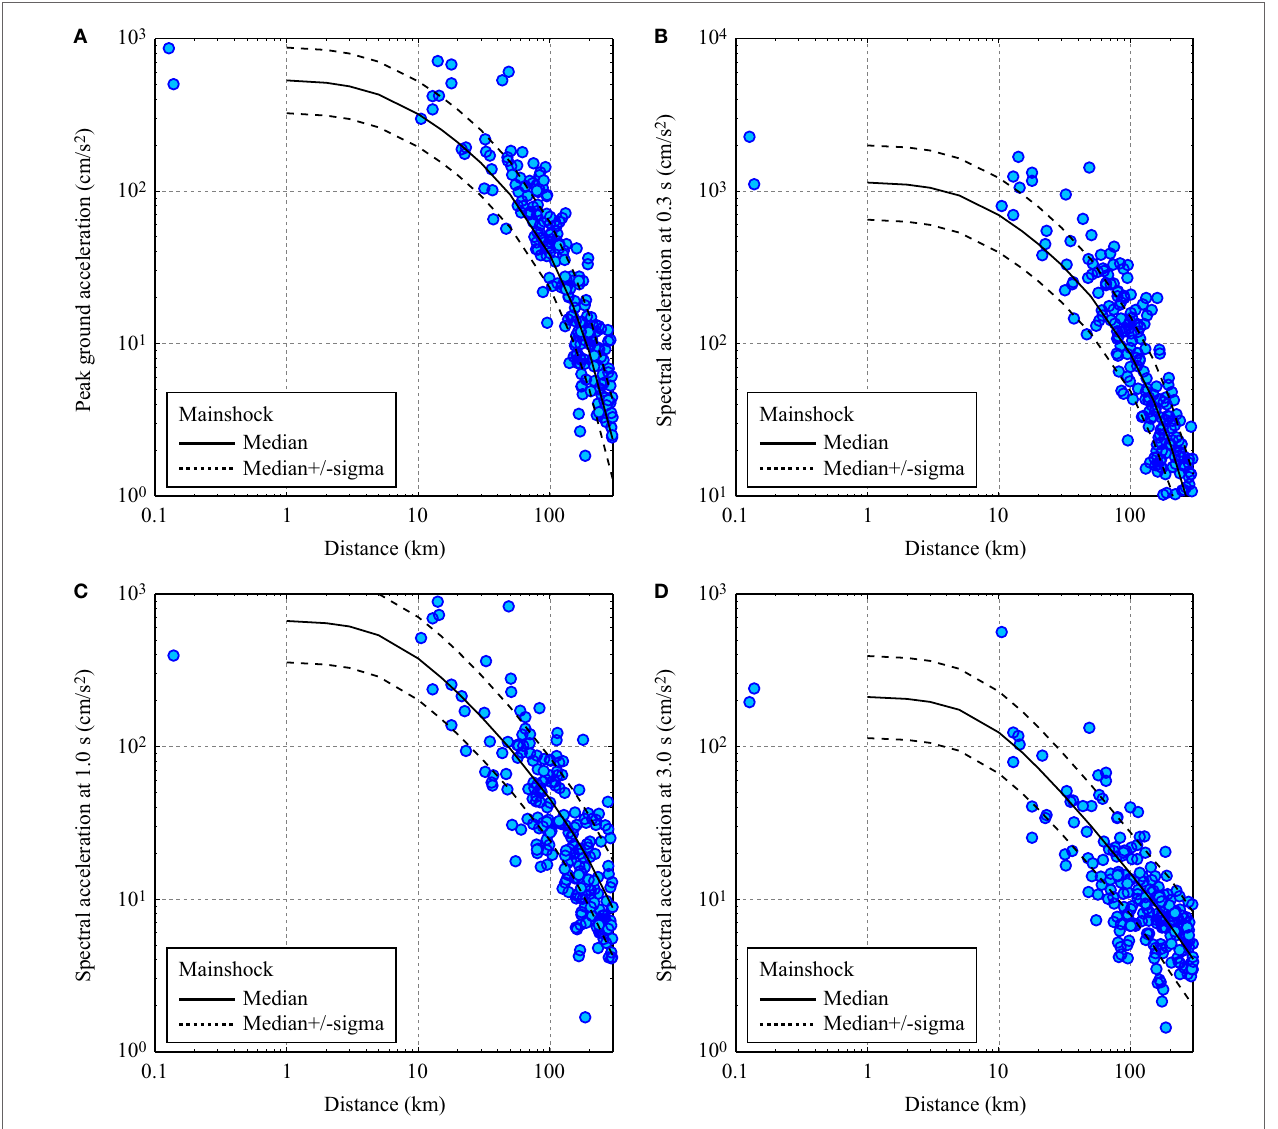
FigUre 9 | comparison of the observed ground motions with the prediction equation by Boore et al. (2014) for the mainshock: (a) peak ground acceleration, (B) spectral acceleration at 0.3 s, (c) spectral acceleration at 1.0 s, and (D) spectral acceleration at 3.0 s